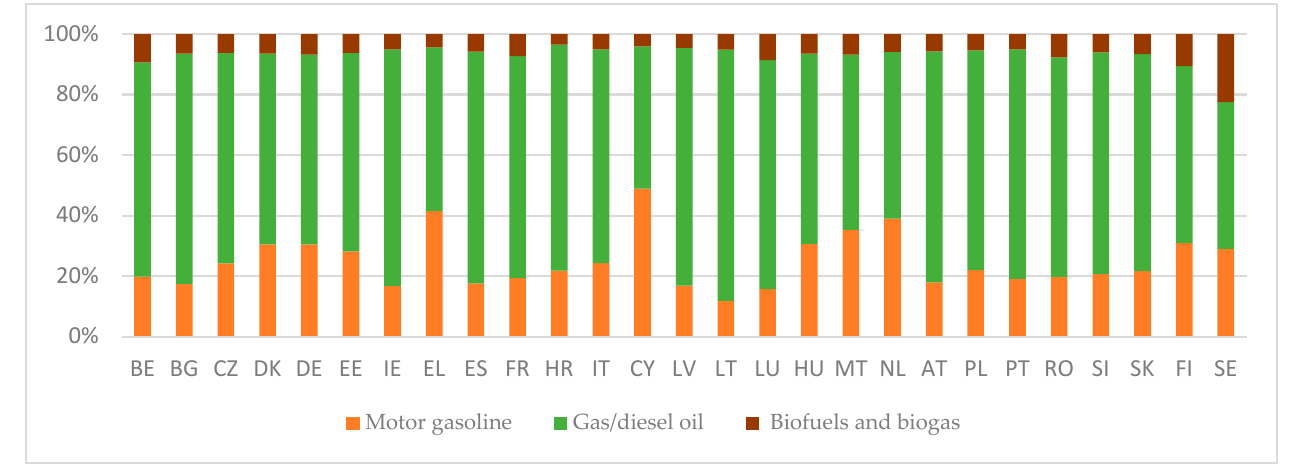
Figure 8. Final consumption of motor gasoline, diesel, biofuels and biogas for transport (shares of total consumption in the country, 2020). Source: Own elaboration based on Eurostat 2022.